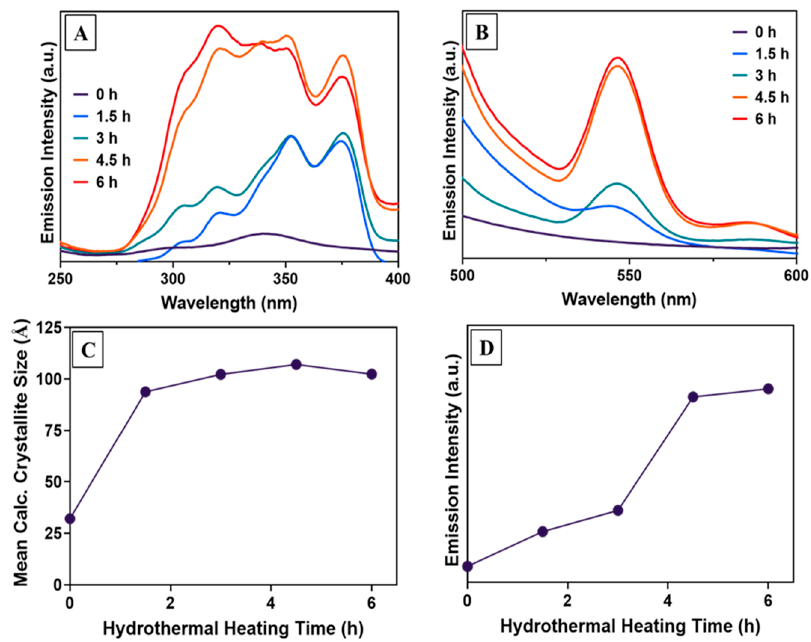
Figure 2. ( A ) Excitation spectrum of CaF 2 :Tb NPs with variable hydrothermal annealing times, monitoring the intensity of the 545 nm emission. ( B ) Emission intensity of the samples when excited by 320 nm radiation. ( C ) Crystallite size data estimated from XRD patterns of each sample using the Scherrer equation. ( D ) Emission intensity at 545 nm plotted vs. increasing hydrothermal heating time.